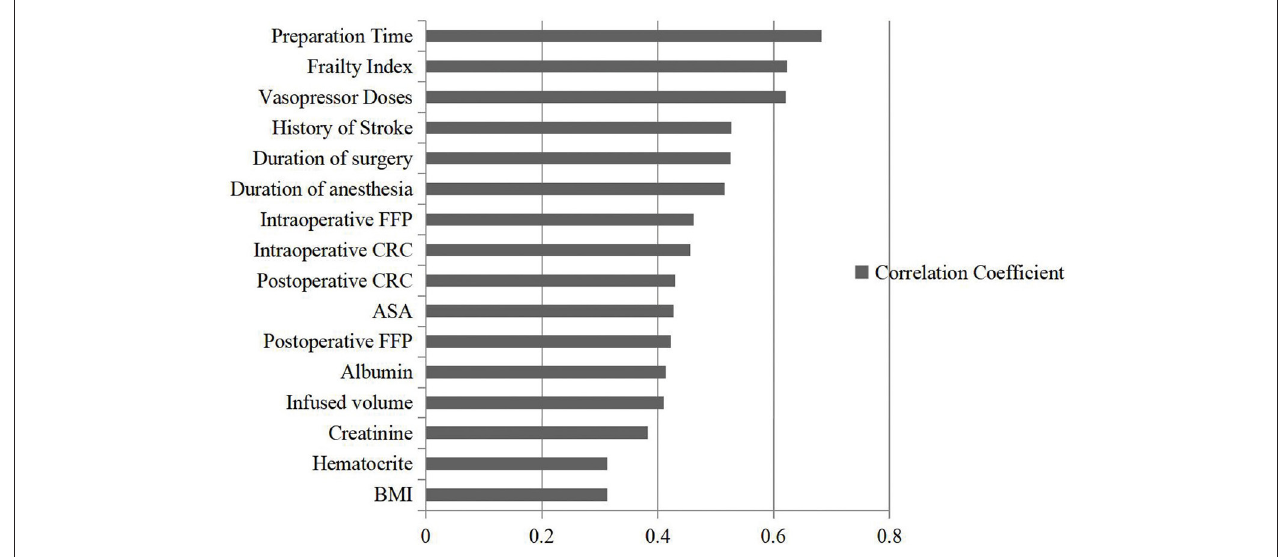
FIGURE 3 | The correlation coefficient of different variables detected by machine learning methods. A correlation coefficient is a number between − 1 and + 1 calculated to represent the linear dependence of the variable and event. The predictor variable with the largest coefficient is considered as the most important predictor; and the predictor variable with the next largest correlation coefficient as the next important variable, and so on.